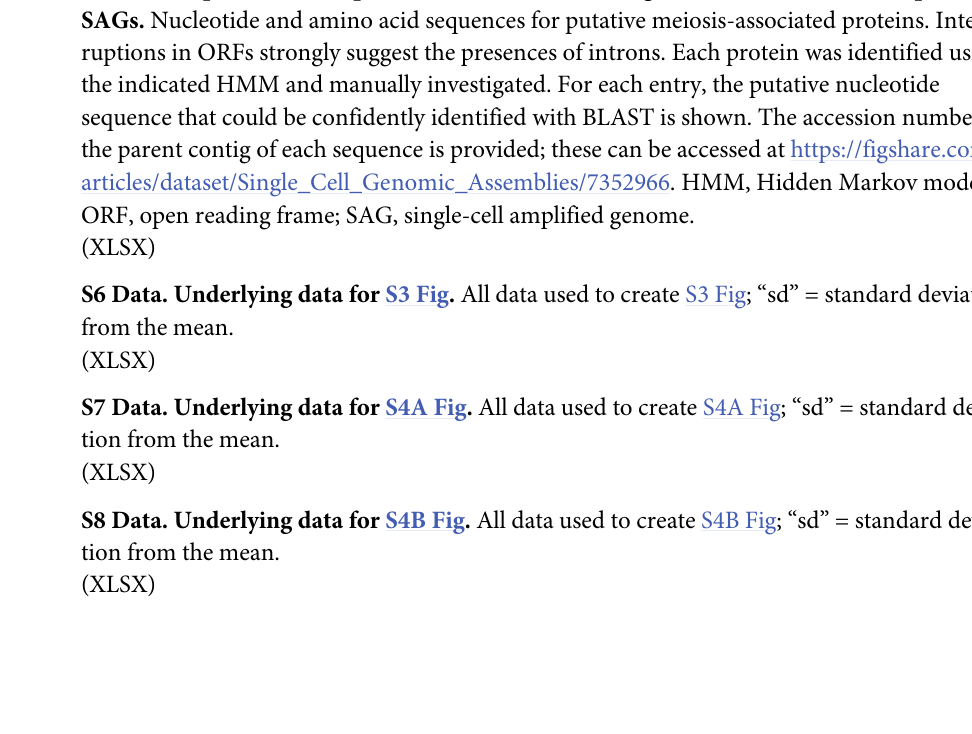
S2 Table. Plasmids used in this study. Note that all functions described are putative and con- structs are codon-optimised for expression in E . coli , unless otherwise stated. S3 Table. Protein sequences. Amino acid sequences for all proteins used in this